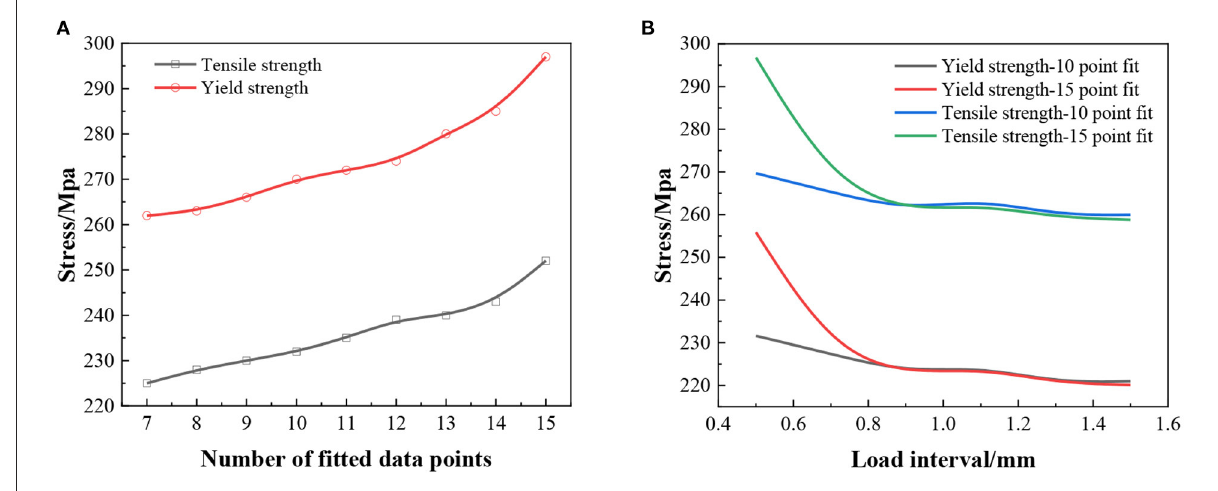
FIGURE2 Calculated results of metal tensile properties, (A) material tensile properties for different data ranges at 0.5mm press-in interval; (B) re-choice of fitted